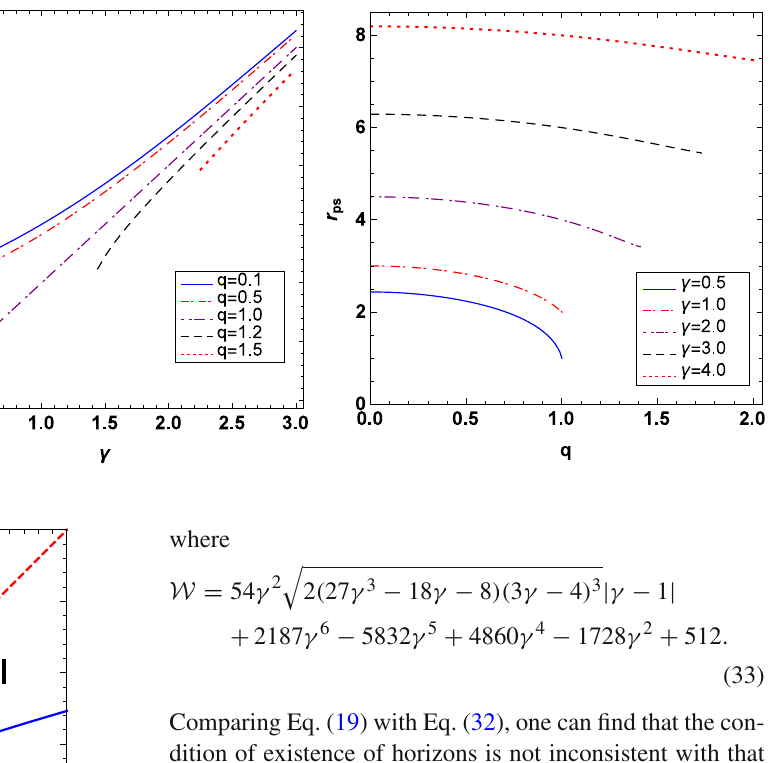
Fig. 1 Change of the photon sphere radius r ps with parameters q and γ in the background of a black hole spacetime with torsion (18).